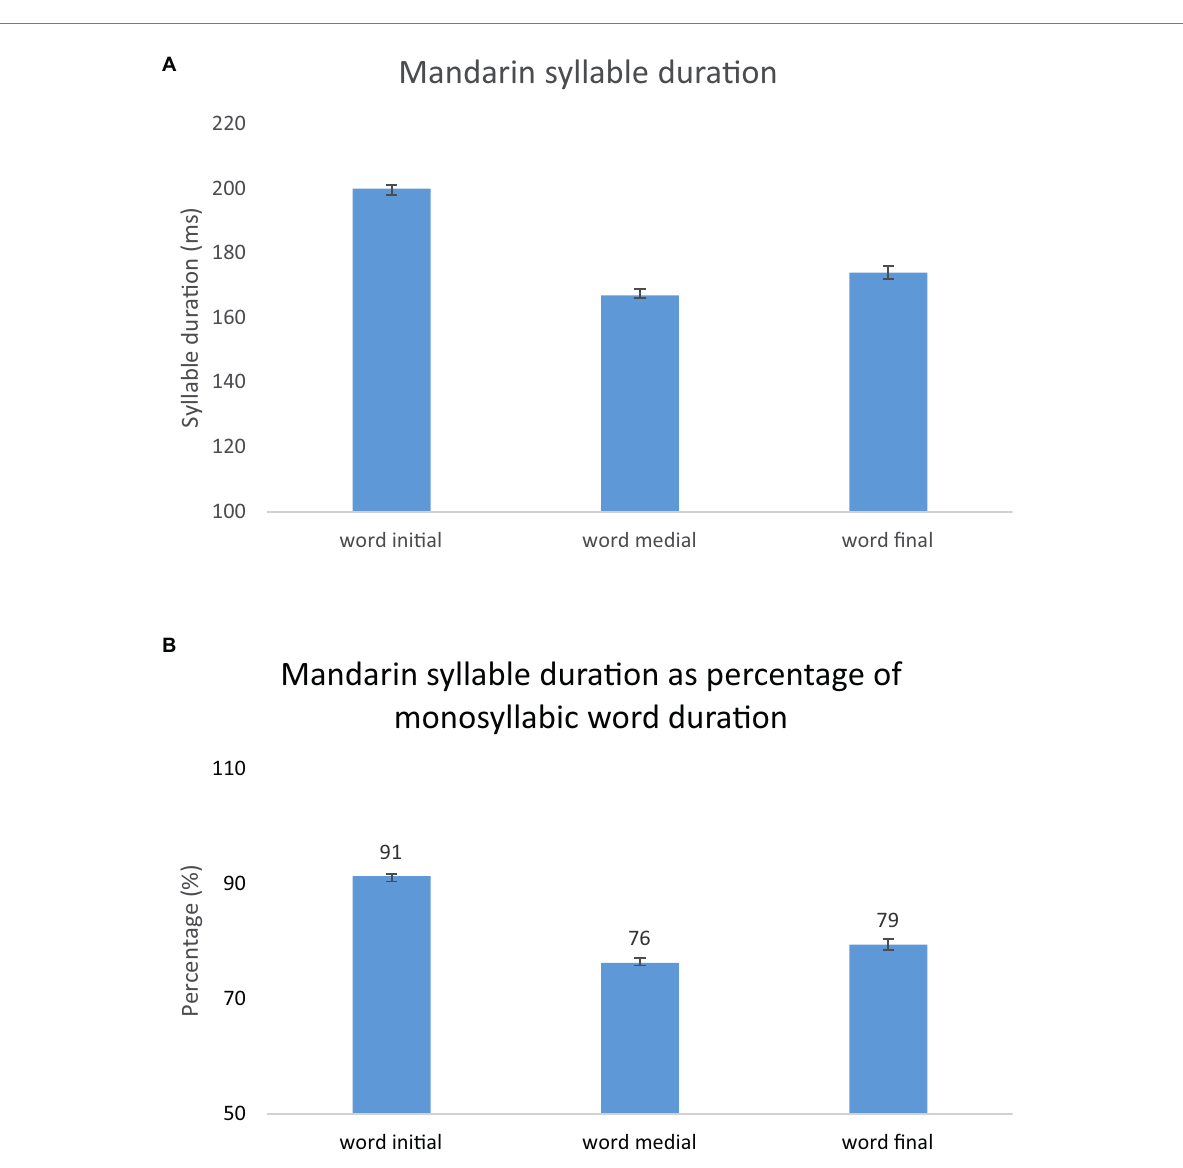
FIGURE 13 Mandarin syllable duration as a function of position in word, in (A) milliseconds, and (B) percentage of monosyllabic word